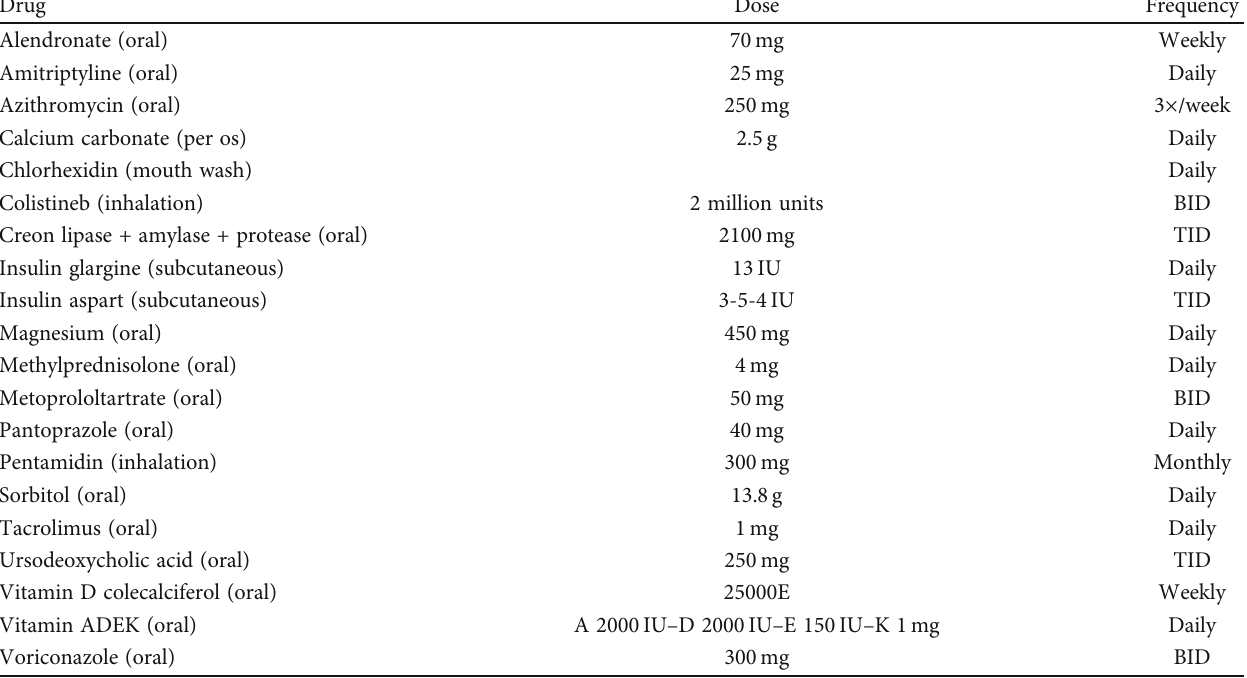
Table 1: Discharge medications from the recent hospitalization.